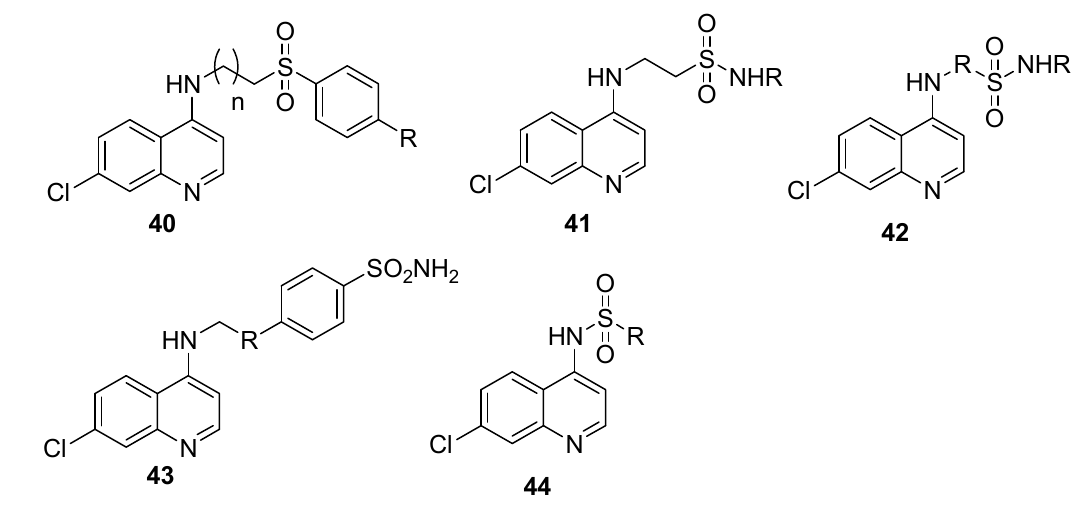
Figure 8. Quinoline-sulfonamide hybrids.